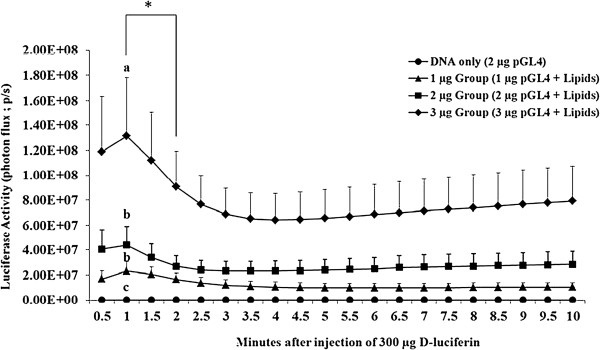
Time courses of bioluminescence emitted from transfected intact antral follicles with increasing doses of luciferase reporter gene. A total of n = 87 follicles were randomly distributed in four different groups (DNA only, 1 μg, 2 μg, and 3 μg groups). DNA only group represents a group of intact follicles (n = 22) transfected with 2 μg pGL4 (a luciferase reporter gene) only; 1 μg group represents a group of intact follicles (n = 22) transfected with 1 μg of pGL4: lipid complexes; 2 μg group represents a group of intact follicles (n = 21) transfected with 2 μg of pGL4: lipid complexes; and 3 μg group represents a group of intact follicles (n = 22) transfected with 3 μg of DNA:lipid complex. After 20 hours transfection, each follicle was imaged with series of 30 sec exposure time and 5 binning up to 10 minutes. Data are plotted as mean ± SEM of Luciferase Activity (Photon Flux; p/s) over time. Values with different superscripts in a group are significantly different (P < 0.05). *indicates significant difference (P < 0.05) compared to each other.